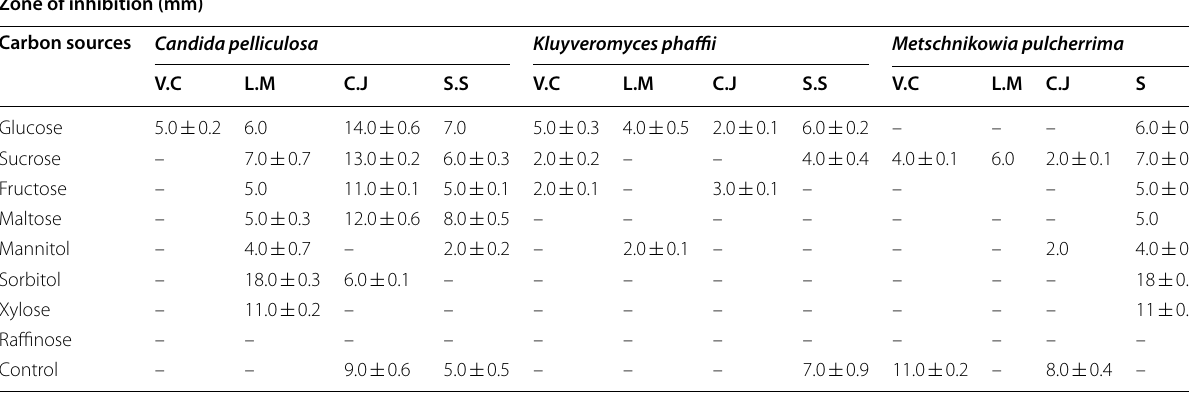
Salmonella sp (S.S) , Campylobacter jejuni (C.J) , Listeria monocytogenes (L.M) and Vibrio cholera (V.C) –, No activity